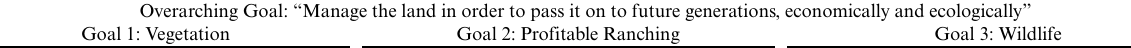
Table 1 . Collaborative adaptive rangeland management (CARM) experiment stakeholder-defined goals, objectives, and monitoring indicators.